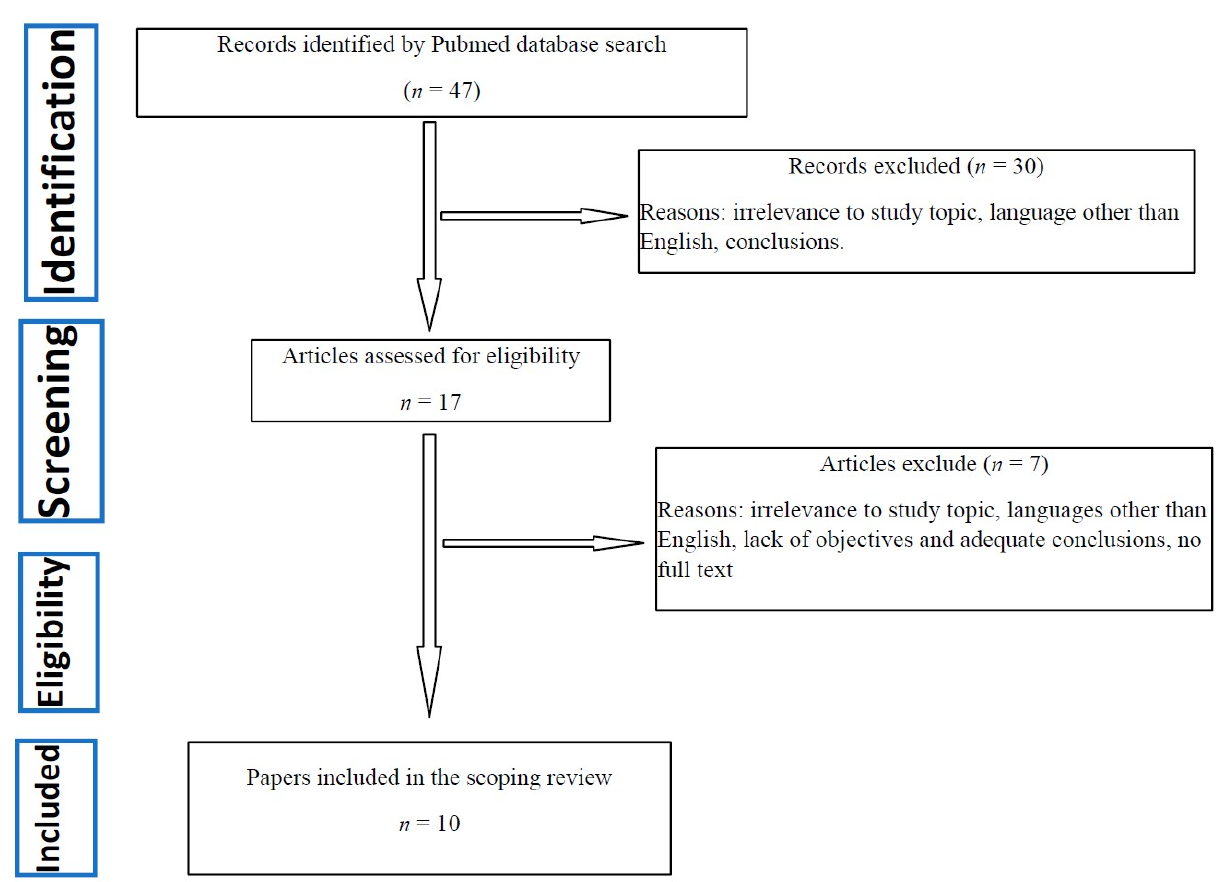
Figure 1. Flowchart of selected manuscripts.